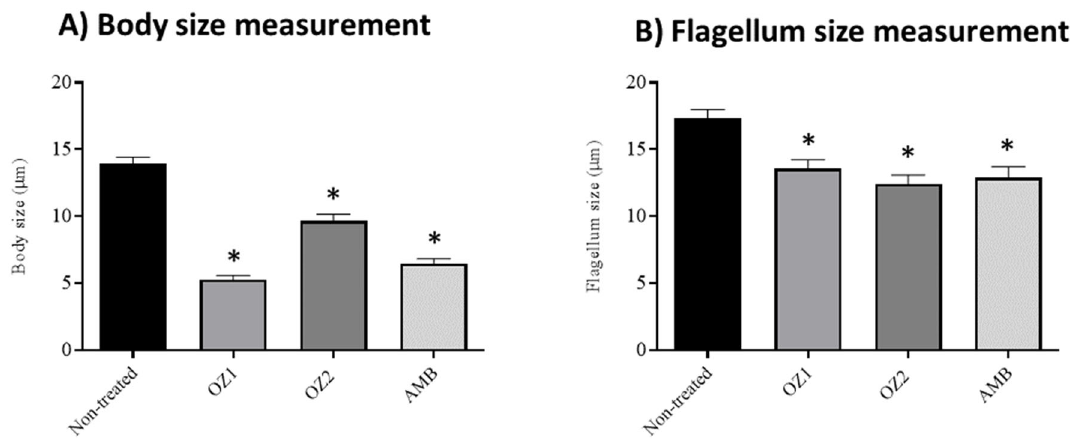
Figure 6. Body ( A ) and flagellum ( B ) measurements of L. tropica promastigotes after 48 h of treatment with OZ1 (300 µ M), OZ2 (200 µ M), and amphotericin B (0.62 µ M). Non-treated parasites were also included in this evaluation. Significant differences between compounds and amphotericin B in comparison with non-treated parasites are indicated as *, p < 0.001 (ANOVA).